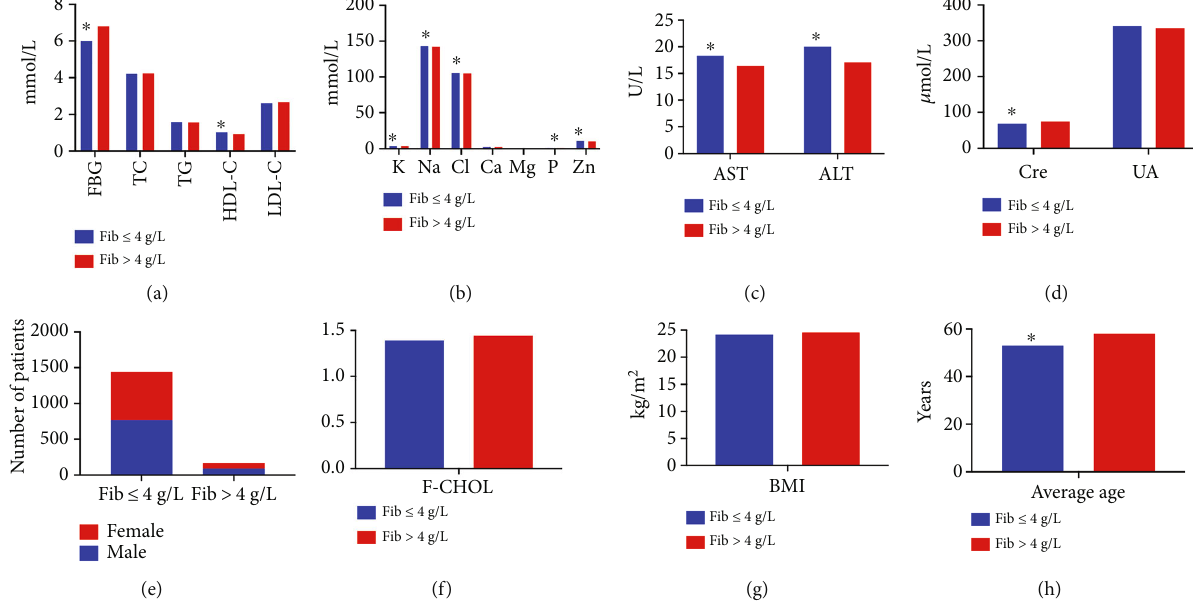
Figure 5: Comparison of di ff erent indicators between the Fib ≤ 4g/L and Fib > 4g/L groups. (a) Comparison of levels of FBG, TC, TG, HDL-C, and LDL-C between the two groups. Compared with the Fib > 4g/L group, the levels of FBG were signi fi cantly lower but levels of HDL-C were higher in Fib ≤ 4 g/L group. (b) Comparison of levels of K, Na, Cl, Ca, Mg, P, and Zn in the blood between the two groups. Signi fi cant di ff erences were observed in K, Na, Cl, P, and Zn between the groups. (c) The levels of AST and ALT in Fib ≤ 4 g/L group were signi fi cantly higher than that in Fib > 4g/L group. (d) Comparison of Cre and UA levels between the groups. The levels of Cre were signi fi cantly lower in Fib ≤ 4 g/L group than that in Fib > 4g/L group. (e) Comparison of the number of male and female patients between the groups. (f) Comparison of levels of F-CHOL between the groups. (g) Comparison of BMI of patients between the groups. (h) The average age of patients in Fib ≤ 4g/L group was signi fi cantly lower than in Fib > 4g/L group. Table 6: Comparison of clinical data of patients in the NSE ≤ 16 : 3 ng/mL and NSE > 16 : 3ng/mL groups.